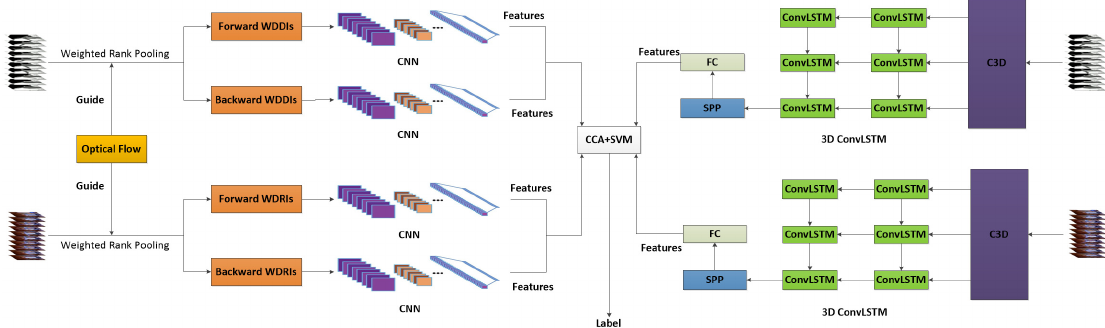
Figure 1. An overview of the proposed hybrid network for multimodal action recognition. The network is built upon the proposed weighted dynamic images, CNNs and 3D ConvLSTM to extract highly complementary information from the depth and RGB video sequences. Canonical correlation analysis is adopted for feature-level fusion and a linear SVM for